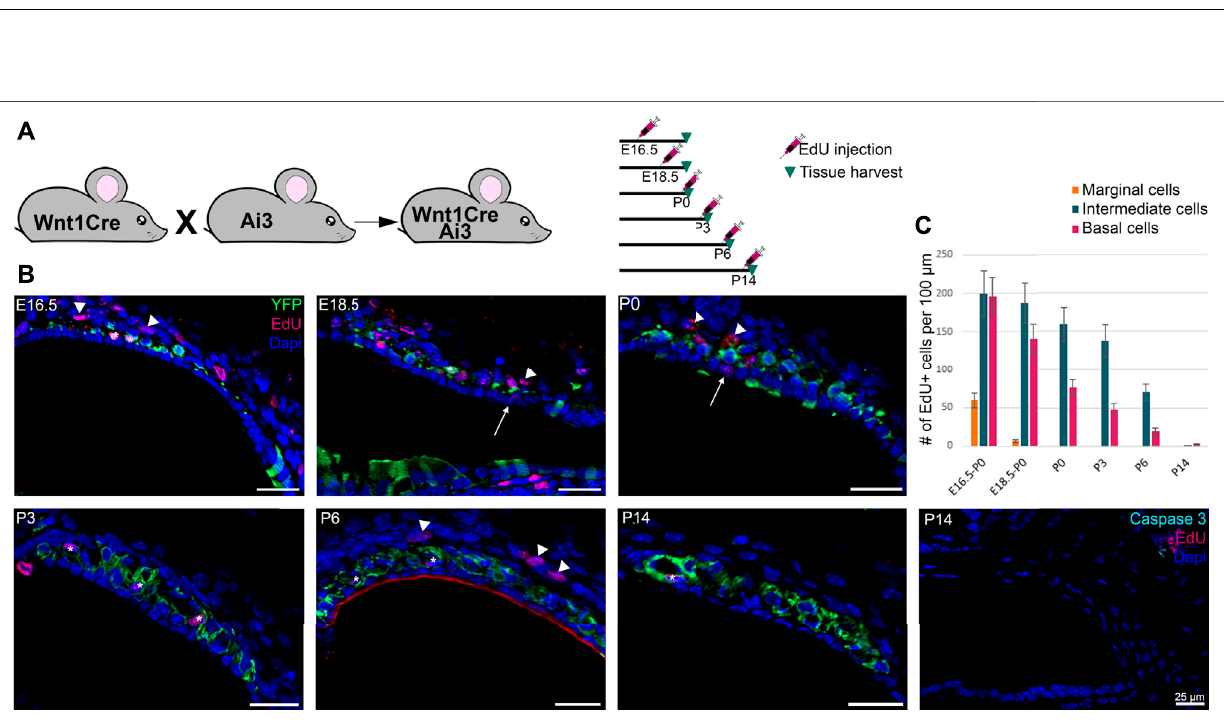
Frontiers in Cell and Developmental Biology |